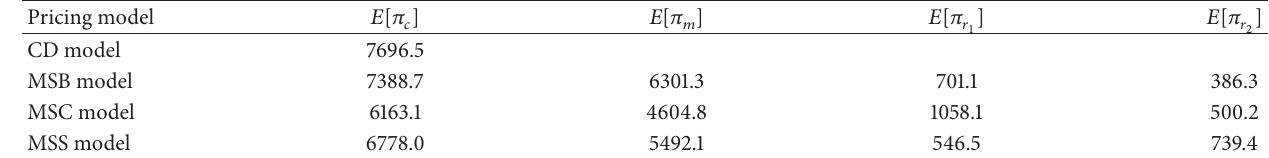
Table 1: Maximum expect profit of total system and every firm under different pricing models.